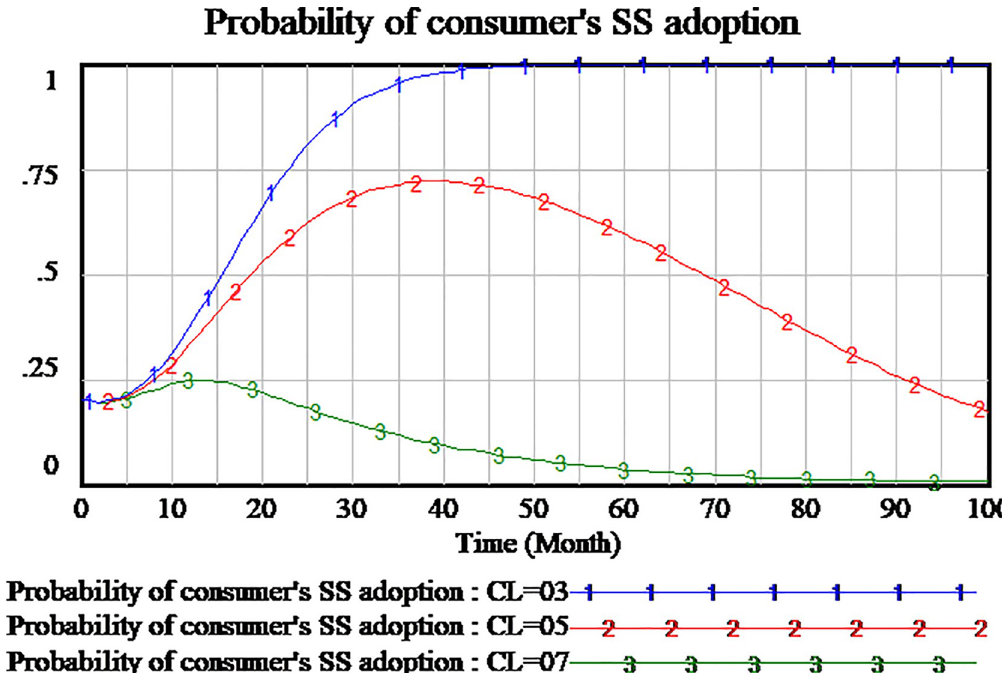
Fig 19. Impact of different cost of low-quality service on consumer.